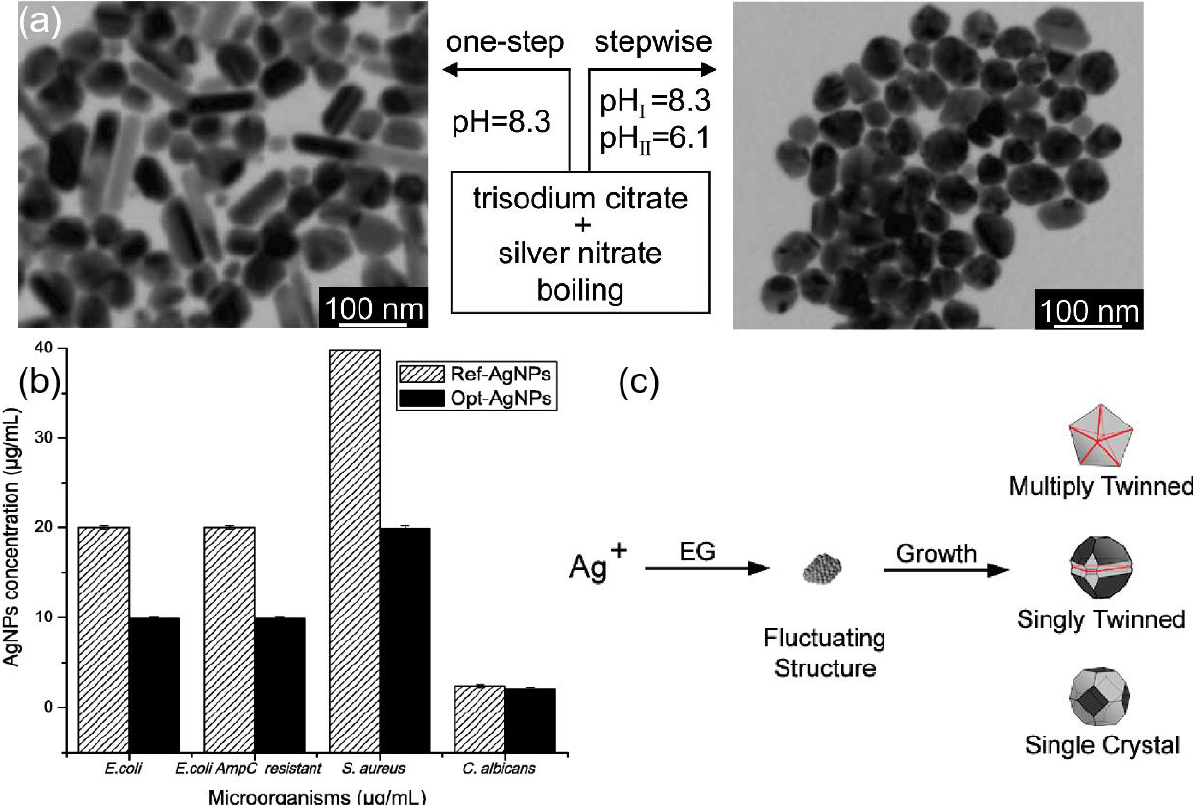
Figure 3. ( a ) A stepwise reduction method, in which the nucleation and growth processes were carried out at high and low pH, respectively, was proposed for the syntheses of spherical silver nanoparticles. Reprinted with permission from Ref. [65]. Copyright 2009, The Journal of Physical Chem-